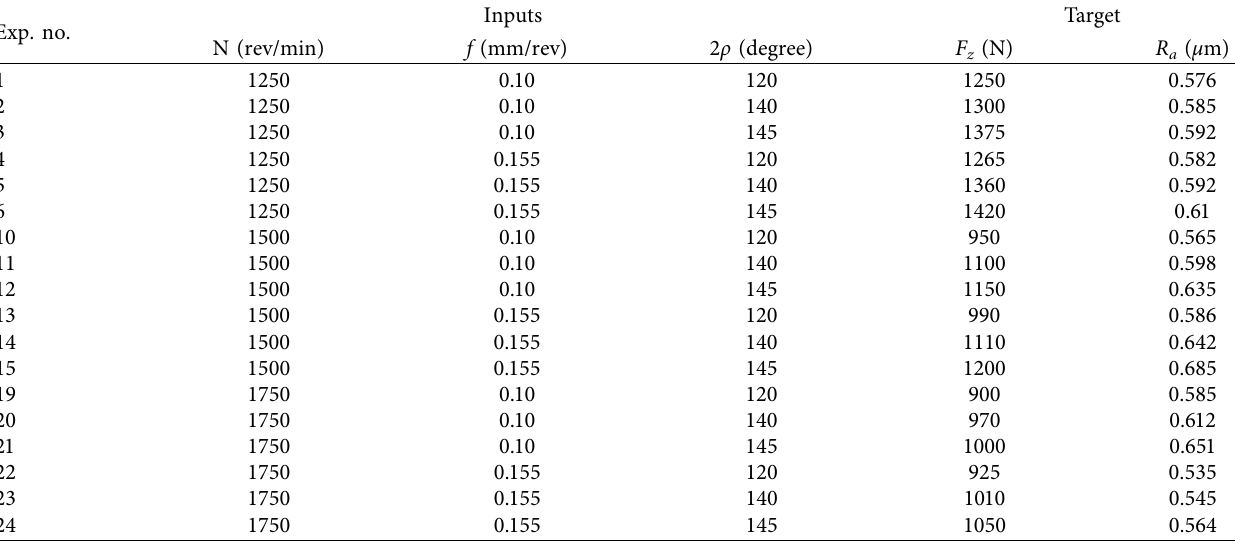
Table 7: Training dataset for LM algorithm.